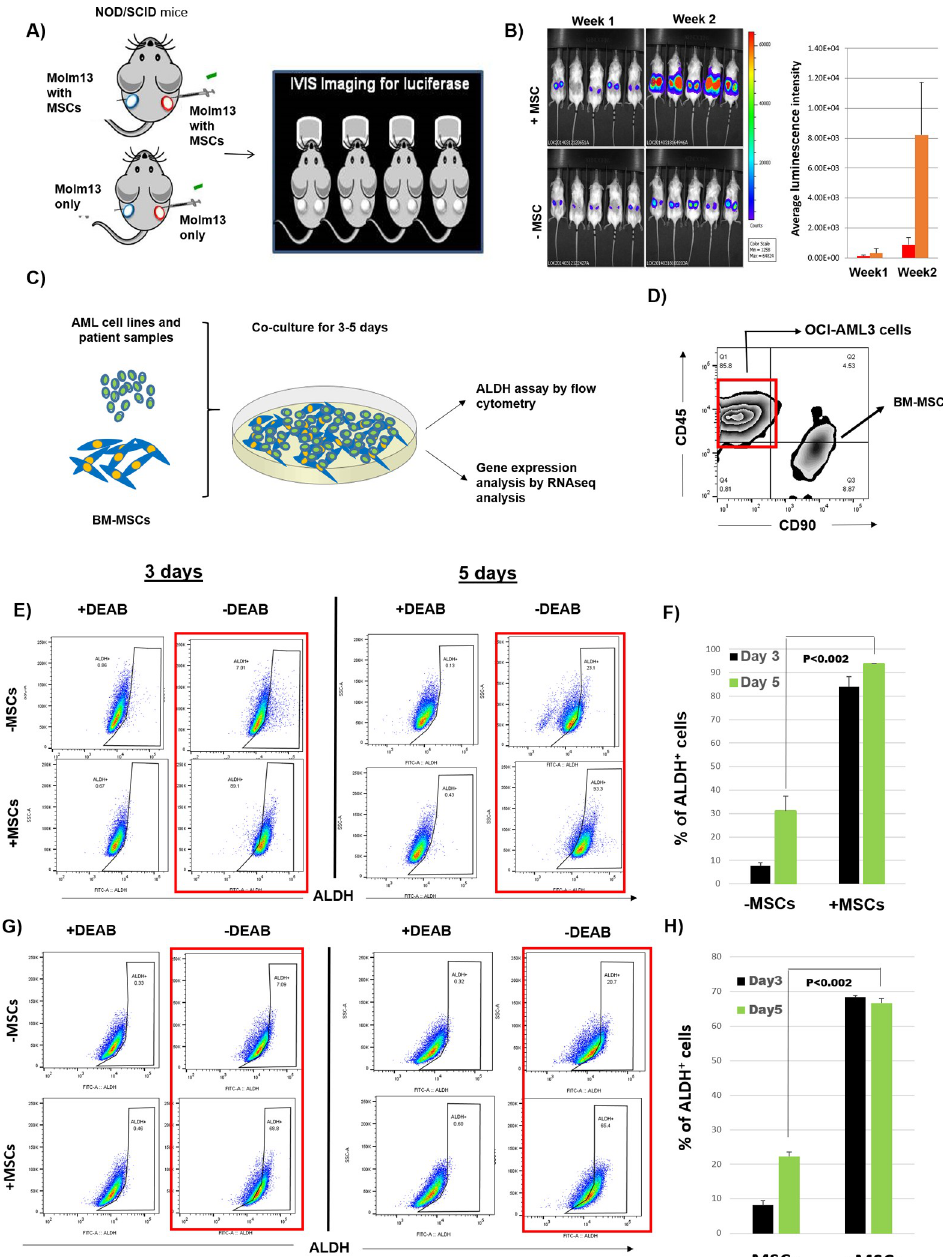
Fig 1. BM-MSCs induce ALDH activity in AML cells and enhance engraftment in mice. (A, B) One million firefly luciferase-expressing AML cells (Molm13) were implanted subcutaneously, with or without 1 million BM-MSCs and 100 μ L of Matrigel, into NOD/SCID mice. Bioluminescence imaging was performed at 1 and 2 weeks to check leukemia engraftment and growth rate. (C) AML cell lines and patient samples were cultured with or without BM-MSCs for 3–5 days. ALDH activity in AML cells was measured using ALDEFLUOR 1 assay. Gene expression analysis was performed by RNA sequencing. (D) Fluorescence-activated cell sorting of OCI-AML3 cells was performed based on phenotype (CD45 + , CD90 - ) to distinguish them from BM-MSCs (CD90 + , CD45 - ). (E) OCI-AML3 cells were cultured with or without BM-MSCs for 3 or 5 days. Cells were stained with ALDEFLUOR 1 , CD45, and CD90. During FACS analysis, MSCs (CD90 + , CD45 - ) were gated and ALDH activity was measured in OCI-AML3 cells by flow cytometry. Data were analyzed on FlowJo software. (F) Histogram representation of the percentage of ALDH + OCI-AML3 cells corresponding to the experiment done in E . (G) The same experiment was done as in E , using HL60 AML cells. (H) Histogram representation showing the percentage of ALDH + HL60 cells corresponding to the experiment done in G . Data are plotted as the mean value with error bars representing standard error. For B , F , and H a linear model with interaction term was used to evaluate the significance. N = 3 for each group.